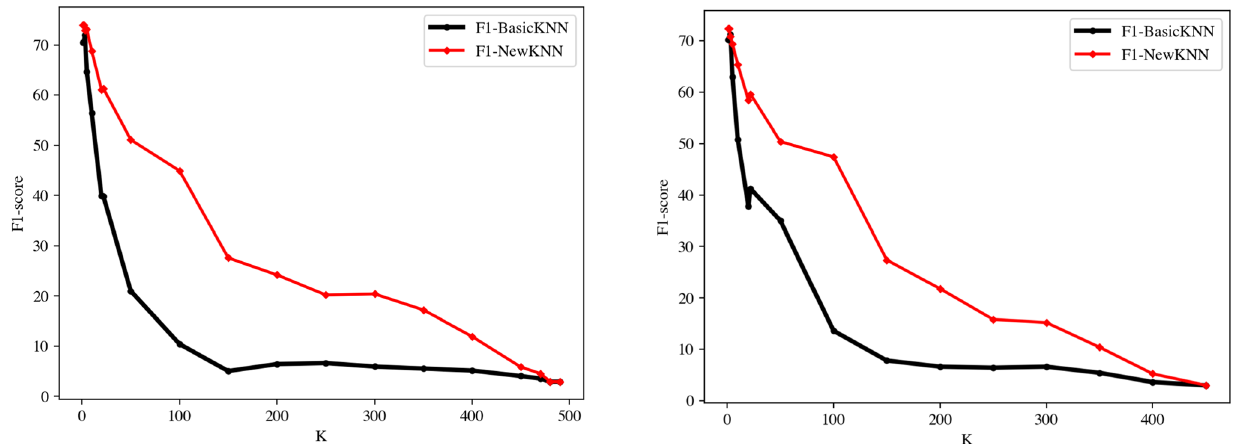
Fig. 5 F1-score evolution for KNN using Jaccard distance with tenfold and fivefold cross-validation on